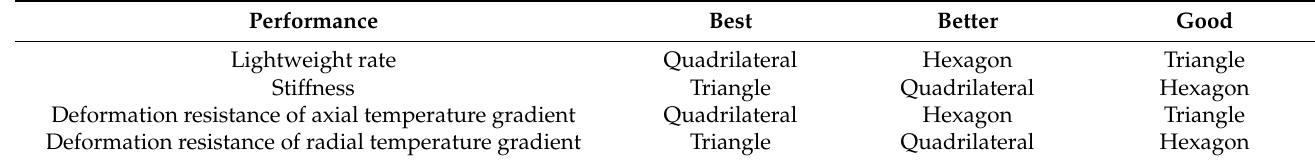
Figure 15. Round and square metal mirrors [32]. In 2018, E. Hilpert’s team from IOF in Germany designed and compared the perfor- mance of five lightweight metal mirrors: solid mirror, drill mirror, open-back mirror with honeycomb, sandwich mirror with honeycomb, and empty mirror (Figure 16) [33]. For the sandwich mirror, the stiff and strong face sheets carry the bending loads, while the core resists shear loads. The results of the modal analysis show that the sandwich mirror with honeycomb has the best mechanical properties (Figure 17). It has the second lightest weight, only after the open-back structure, which precisely verifies the sandwich mirror’s advantages in many aspects given in Section 1. Moreover, this experiment has laid a the- oretical and practical foundation for the team’s next-generation AM metal mirrors.